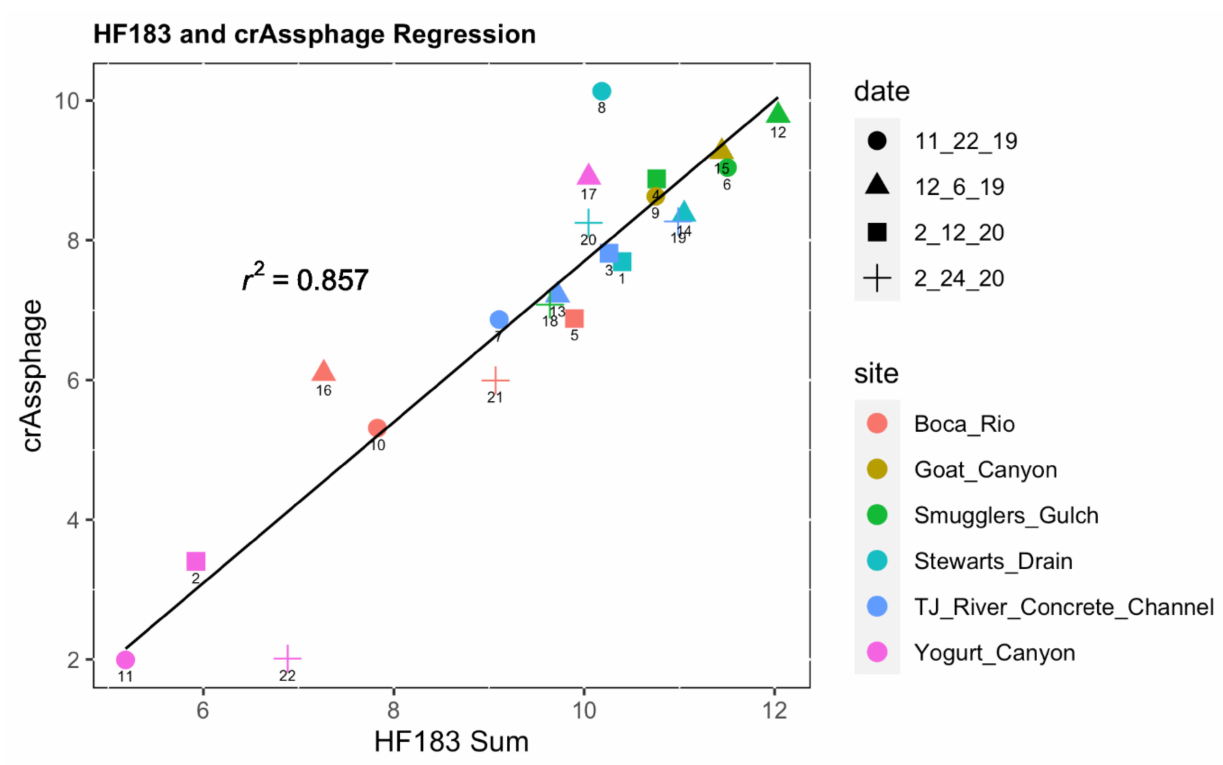
Figure 4. Regression Plot of crAssphage and HF183